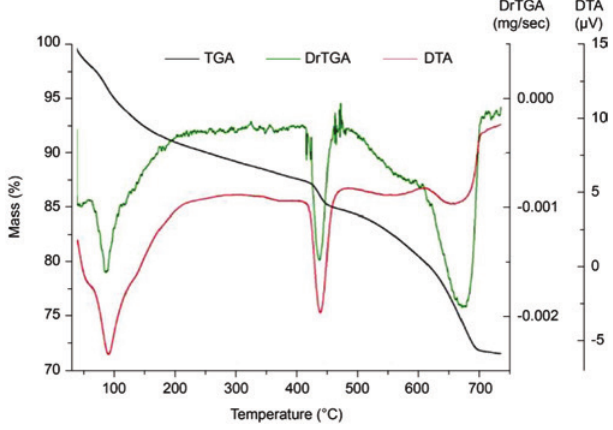
Thermal analysis of comminuted cement paste (w/c 0.5)